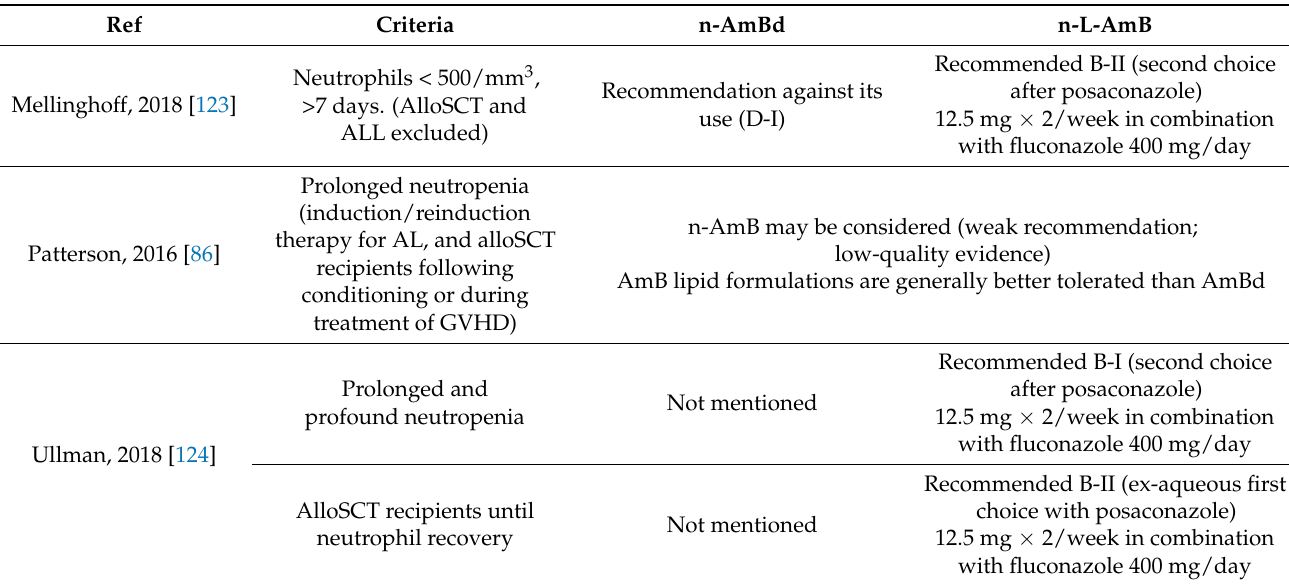
Table 2. Guidelines for prophylactic use of nebulized AmB in hematological